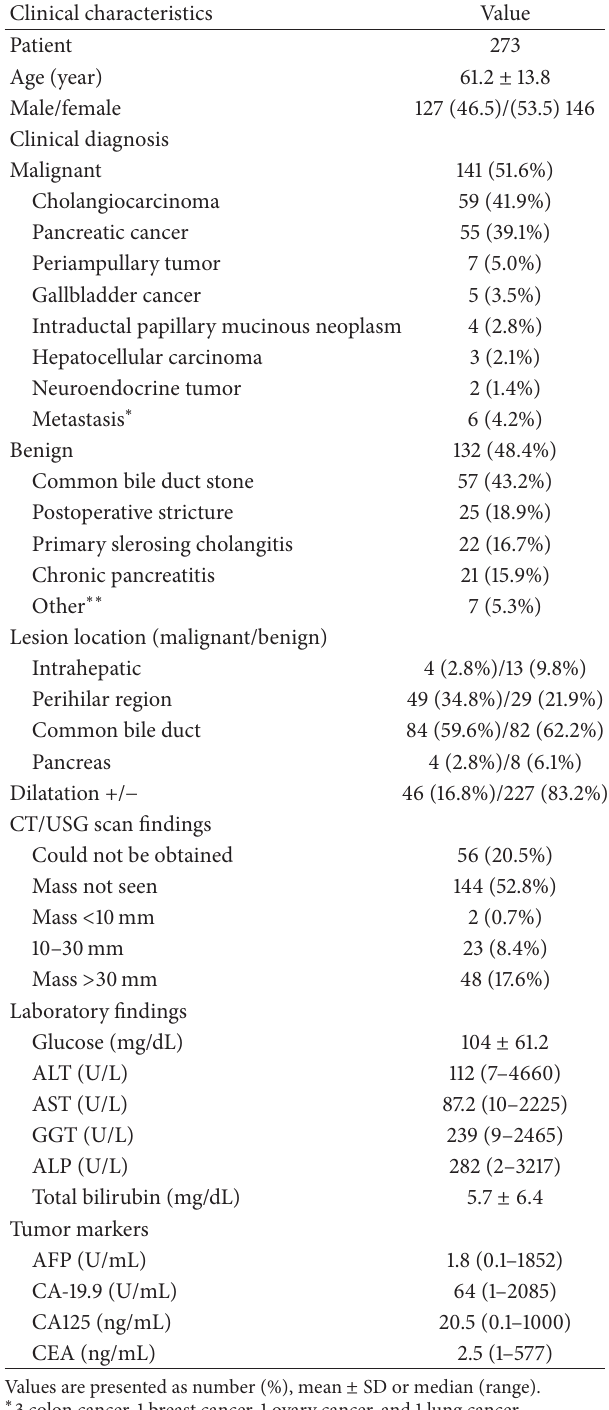
Table 1: Baseline